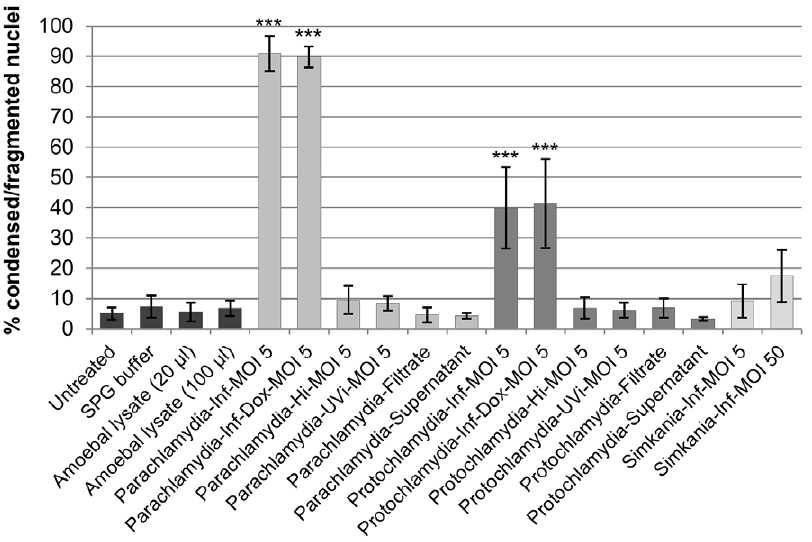
Figure 5. Parachlamydiaceae -induced changes in nuclear morphology in S2 cells depend on bacterial activity. S2 cells were either left untreated or were treated with SPG buffer, amoebal lysate, infectious Parachlamydiaceae ( Pa. acanthamoebae or P. amoebophila ; MOI 5) in the absence (Inf) or presence of the protein synthesis inhibitor doxycycline (Inf-Dox), heat-inactivated bacteria (Hi), UV- inactivated bacteria (UVi), a sterile-filtrate of the suspension of purified infectious bacteria (Filtrate) or a supernatant collected 48 h p.i. from an infected (MOI 5) apoptotic culture (Supernatant). For comparison, cells treated with infectious S. negevensis Z (MOI 5 or 50, as indicated) are shown. After 48 h incubation, DNA was stained with DAPI and the proportion of nuclei with altered morphology was determined. Mean values and standard deviations of six replicates (derived from three independent experiments) are shown. At least 500 nuclei per replicate were considered. Statistically significant differences compared to the untreated cells are indicated (ANOVA & Scheffe´; ***, p # 0.001; **, p # 0.01; *, p #